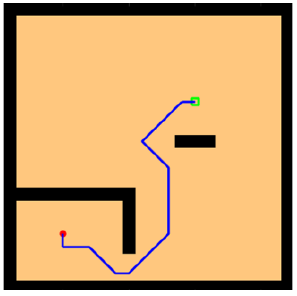
Figure 13. Water maze experiment with the U-shaped obstacles.